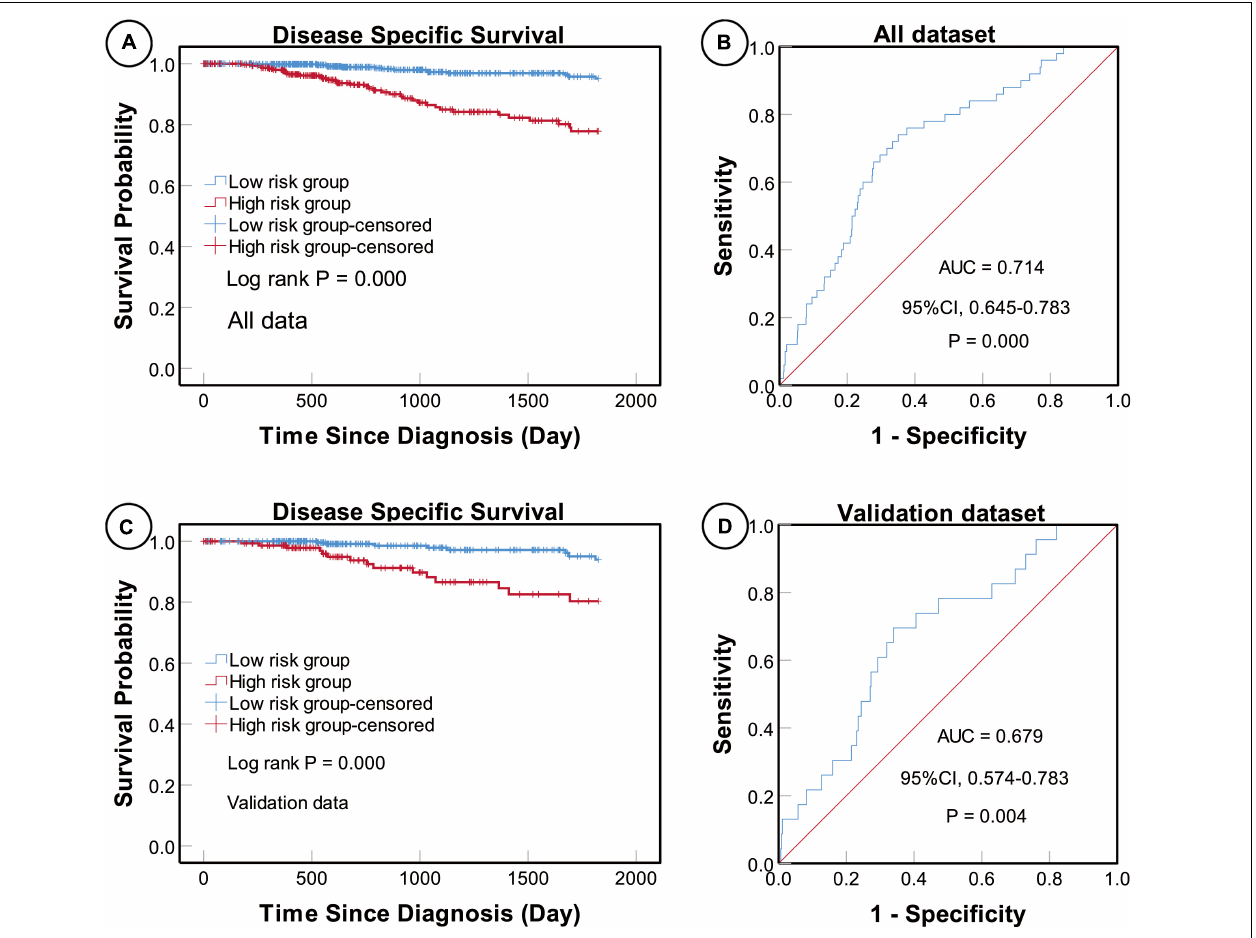
FIGURE 3 | Kaplan–Meier (KM) and receiver operating characteristic (ROC) curves of disease-specific survival (DSS) according to the five-miRNA signature. KM curves of DSS for high- and low-risk groups in the total (A) and validation (C) datasets. The sensitivity and specificity of the five-miRNA signature for predicting DSS of patients in the total (B) and validation (D)